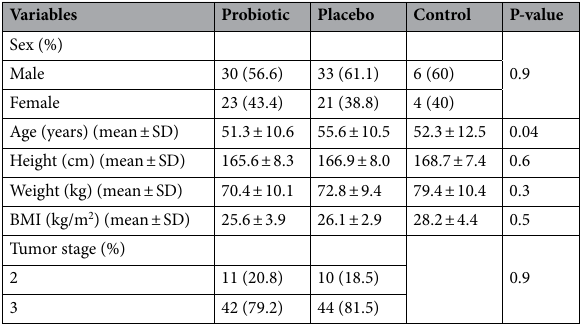
Table 8. Baseline characteristics of the participants in the present study. BMI Body mass